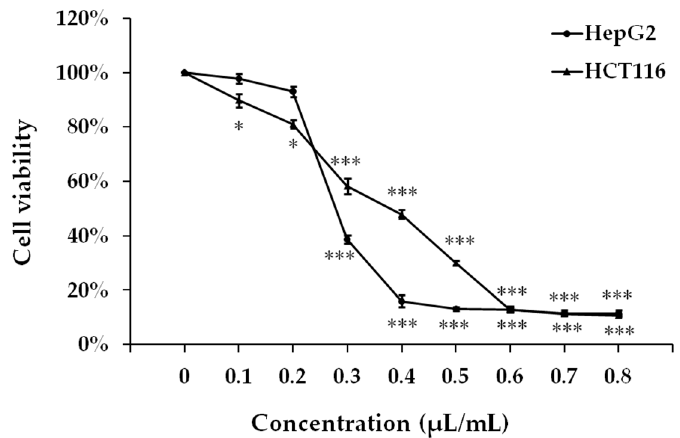
Figure 3. Effect of GOEO on cell viability in cancer cell lines HepG2 and HCT116. The significant differences of cell viability on different concentration compared with control (control group was set to 100%).